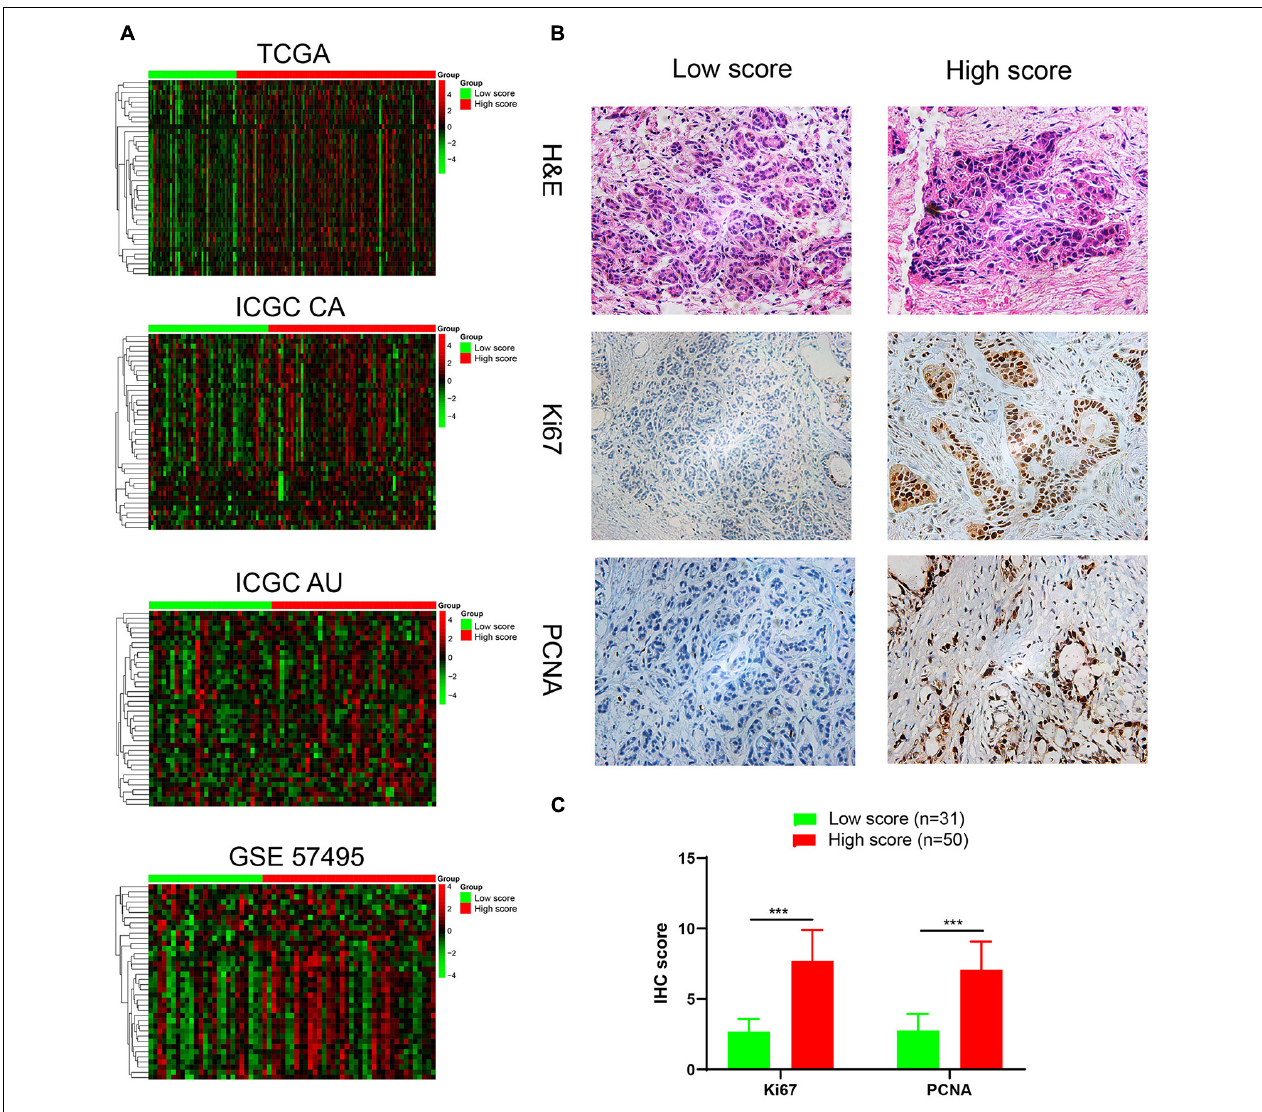
FIGURE 6 | Identification and validation of a highly proliferative subgroup of PDAC. (A) Heatmap showed that G1/S transition pathway was obviously enriched in high score group. We used kmeans clustering to draw heatmaps, and the lines left to heatmaps represent that the genes at ends of the lines had a high correlation. And the gene names in each row from top to bottom are ANXA1, AURKA, BCAT1, C10orf99, CCNA2, CCNB1, CCND1, CCNE1, CDC25C, CDC45, CDC6, CDK1, CDK2, CDK2AP2, CDK6, CDKN3, CDT1, E2F1, E2F7, E2F8, EGFR, EIF4EBP1, EZH2, GMNN, GTSE1, IQGAP3, KIF14, MCM10, MCM2, MCM4, MUC1, ORC1, ORC6, PML, PSME2, RCC1, RRM2, SFN, TNKS1BP1, TYMS. (B) H&E staining and immunohistochemical analyses of Ki-67, PCNA were performed on the tumor sections (low score group, n = 31; high score group, n = 50) (C) The IHC scores of Ki-67 and PCNA in low score ( n = 31) and high score ( n = 50) groups. *** P <